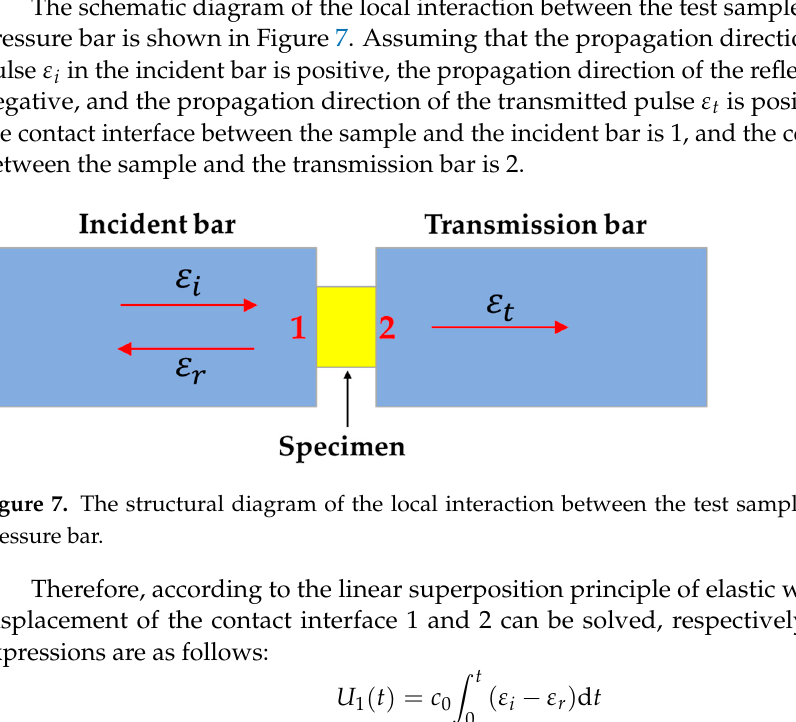
between the sample and the transmission bar is 2.